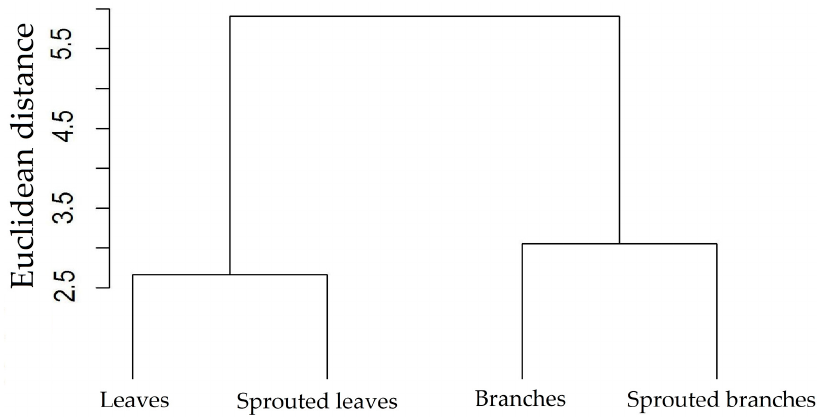
Figure 4. Dendrogram showing the grouping at Euclidean distance of leaves and branches according to the chemical attributes measured before and after the management of the above ground mass in Central Amazonian commercial rosewood plantations.